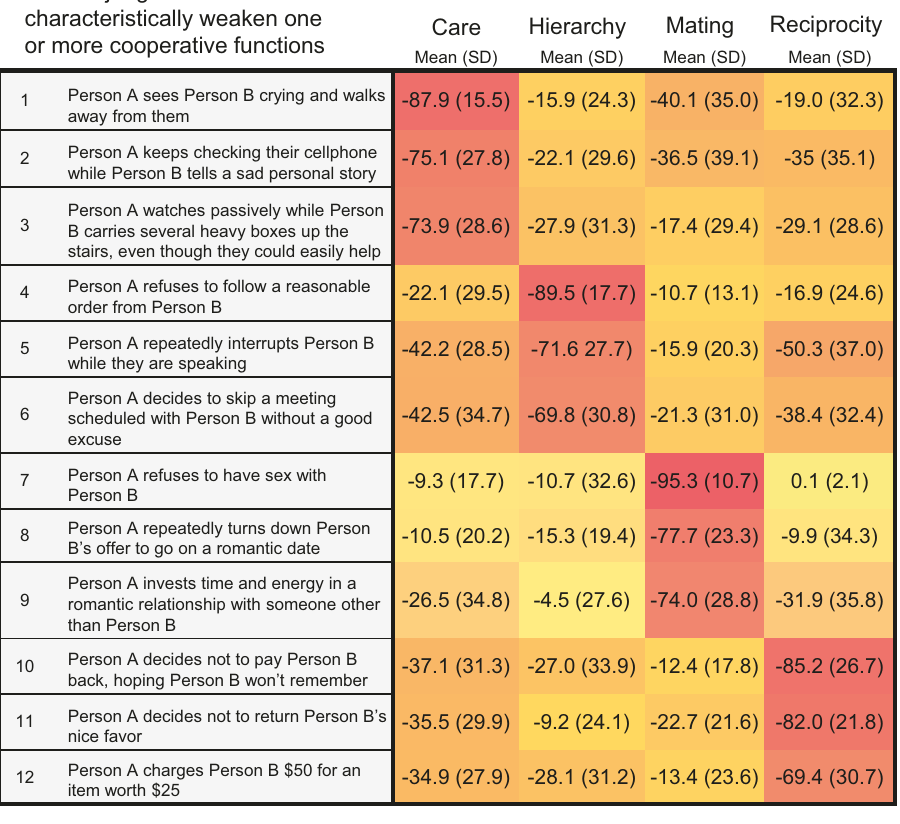
Fig. 4 Characteristic function-weakening actions. Heatmap showing mean ratings of judges ( n = 15) of the extent to which each action characteristically would neglect or violate (weaken) the care, hierarchy, mating, and reciprocity functions, respectively, between any two people (i.e., not assuming the relationship between “ Person A ” and “ Person B ” should in fact serve any of those functions). These items were chosen as experimental stimuli from a much larger set by an algorithm using the judges ’ ratings, where − 100 represents the most characteristic function-weakening effect (see Methods). Darker shades represent more extreme ratings. Note: when rating actions on the hierarchy dimension, judges were asked to imagine that Person A was in a subordinate role, speci fi cally; when rating actions on the care dimension, judges were asked to imagine that Person A was in a caregiving (as opposed to care-seeking) role, speci fi cally. Source data are provided as a Source Data fi